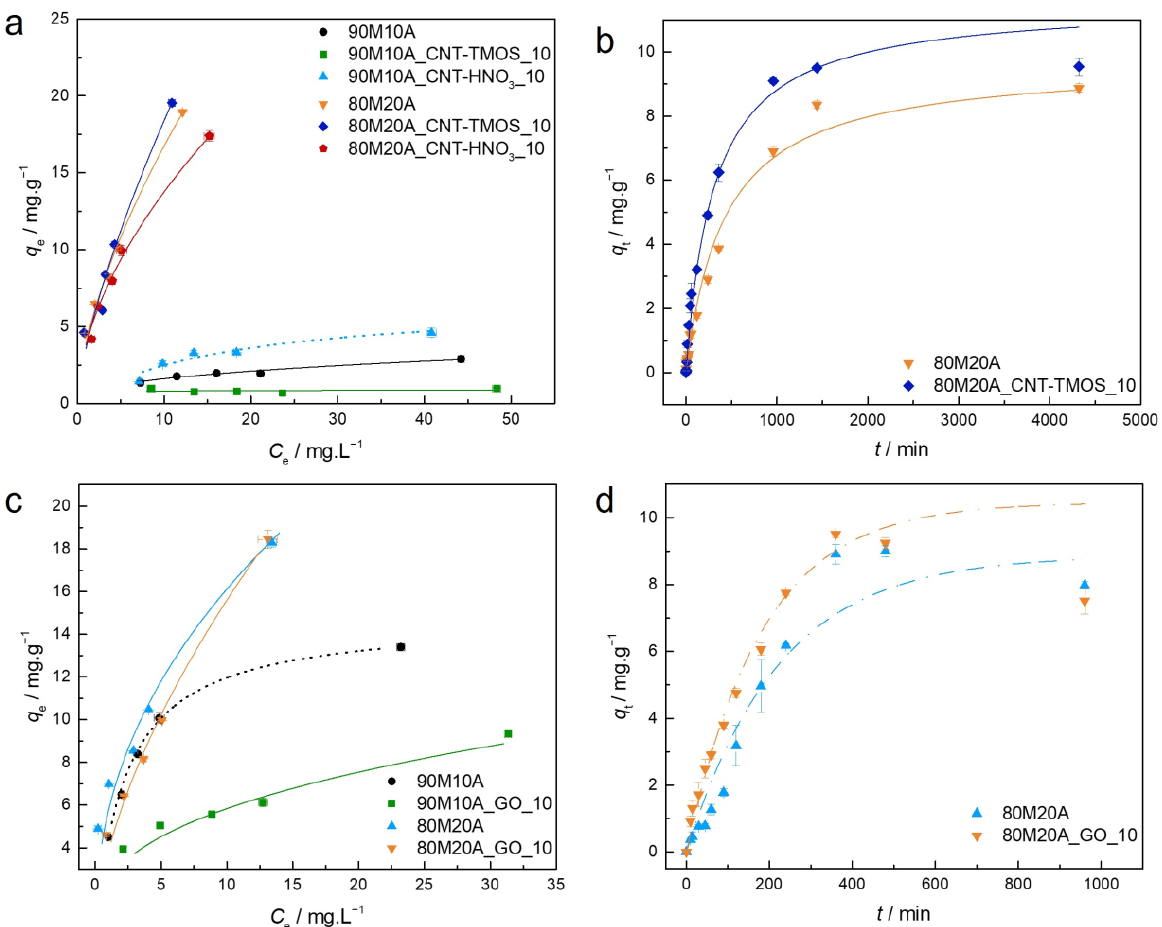
Figure 6. ( a , c )—Experimental equilibrium data and the best fitted isotherm model for adsorption of amoxicillin into the studied aerogels (dotted line—Langmuir; solid line—Freundlich). ( b , d )— Representative plots of the fit of non-linearized form of pseudo-first order (dashed line) or pseudo- second order (solid line) equations to the data of experimental adsorption capacity as function of time, for the studied adsorbents towards amoxicillin ( C 0 =25 ppm, 15 rpm, 20 °C).